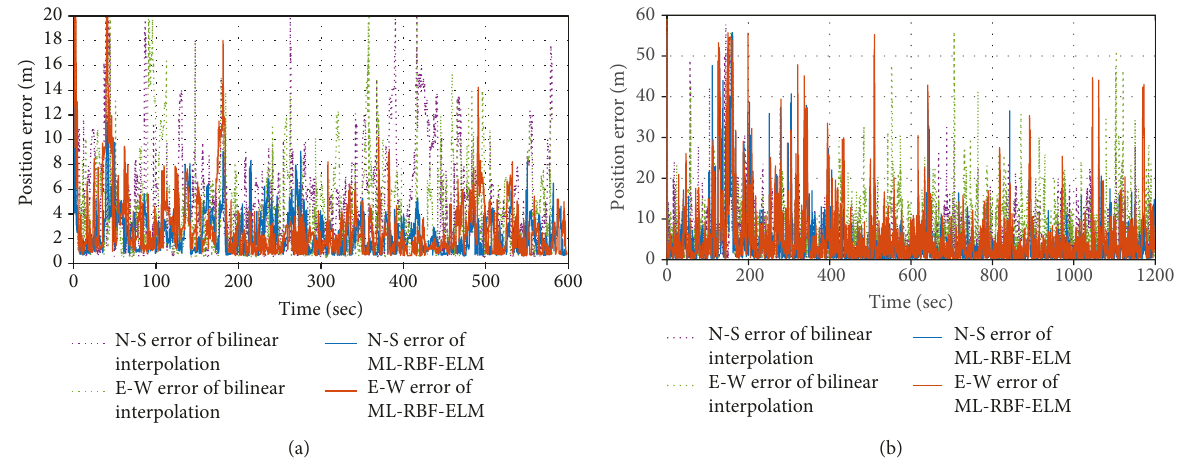
Figure 8: BKF-based TRN RMS errors. (a) DTED level 3 result. (b) DTED level 2